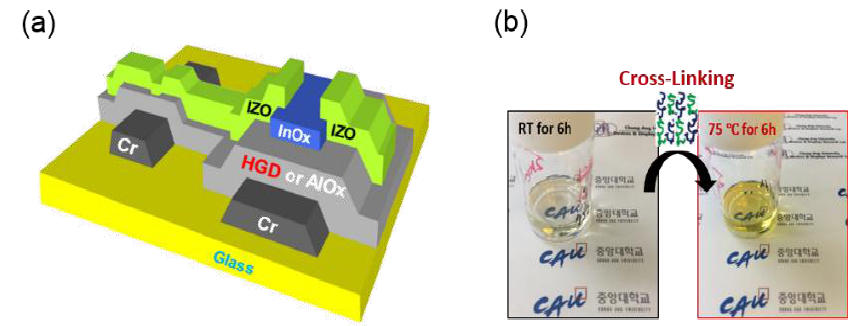
Figure 1. ( a ) Schematic illustration of InO x TFTs using AlO x or HGD gate dielectric layer; ( b ) Photographs of an HGD solution before and after a thermal cross-linking.